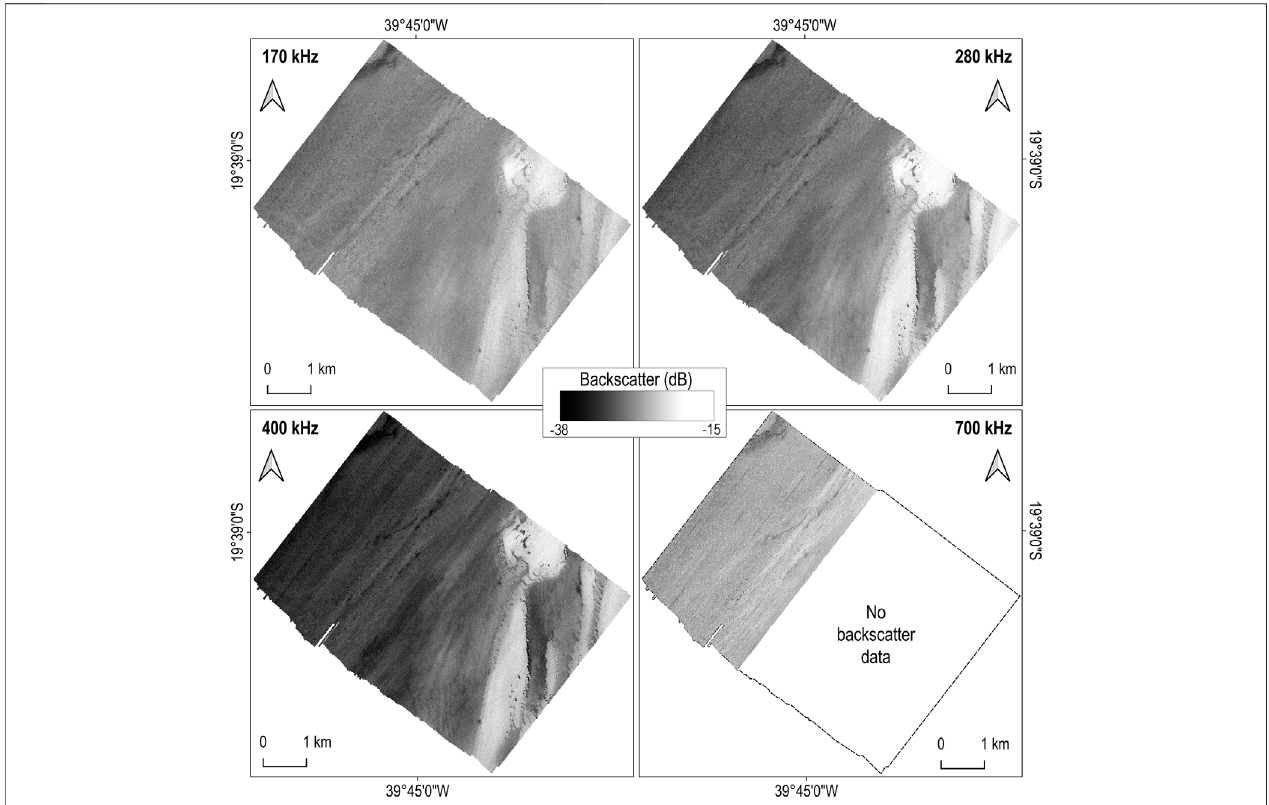
FIGURE 6 | Backscatter mosaics for each operating